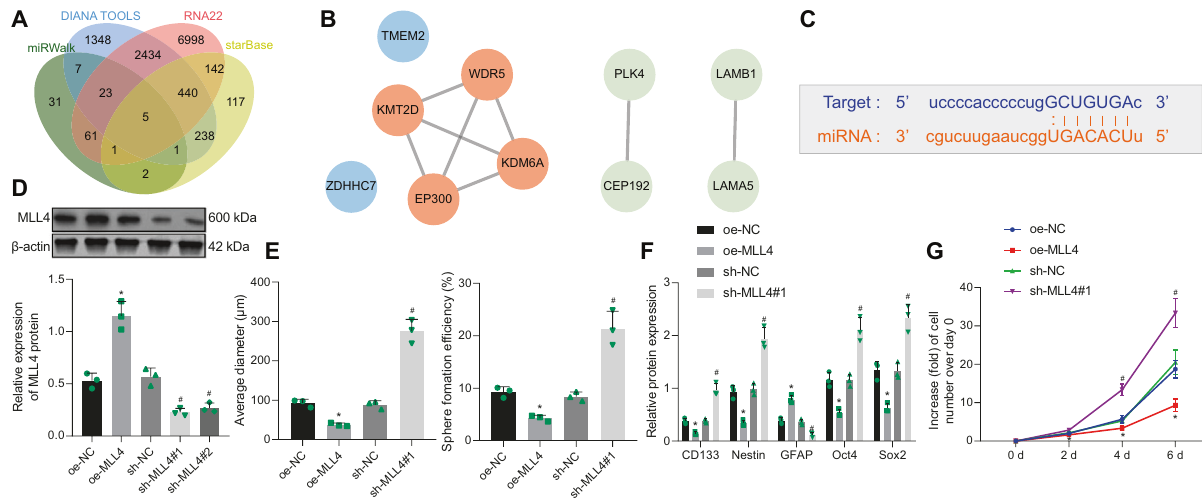
Fig. 4 MLL4 inhibits the properties of GSCs. A Venn diagram of the target genes of miR-27b-3p predicted by the miRWalk (http://mirwalk. umm.uni-heidelberg.de/), DIANA TOOLS (http://diana.imis.athena-innovation.gr/DianaTools/index.php?r = microT_CDS/index), RNA22 (https:// cm.jefferson.edu/rna22/) and starBase (http://starbase.sysu.edu.cn/) databases. B PPI network of the target genes and the related genes constructed using STRING database (https://string-db.org/). The core degree was calculated via Cytoscape (https://cytoscape.org/). Higher degree of gene core corresponds to redder color of the circle; conversely, lower degree of gene core corresponds to bluer circle. C The miR- 27b-3p binding sites in the MLL4 3 ′ UTR predicted by the starBase database. D The expression of MLL4 in GSCs in GSCs transfected with oe- MLL4 or sh-MLL4 measured by Western blot analysis. E The formation rate and diameter of spheres in GSCs transfected with oe-MLL4 or sh- MLL4. F Expression of stem cell-related proteins CD133, Nestin, Oct4, Sox2, and GFAP in GSCs transfected with oe-MLL4 or sh-MLL4 measured by Western blot analysis. G Viability of GSCs transfected with oe-MLL4 or sh-MLL4. * p < 0.05 vs. the oe-NC group. # p < 0.05 vs. the sh-NC group. Measurement data were depicted as mean ± standard deviation. Comparison of data among multiple groups was conducted by one-way ANOVA followed by Tukey ’ s post hoc test. The data among multiple groups at different time points were compared using repeated-measures ANOVA with Bonferroni ’ s post hoc test. Cell experiments were repeated three times